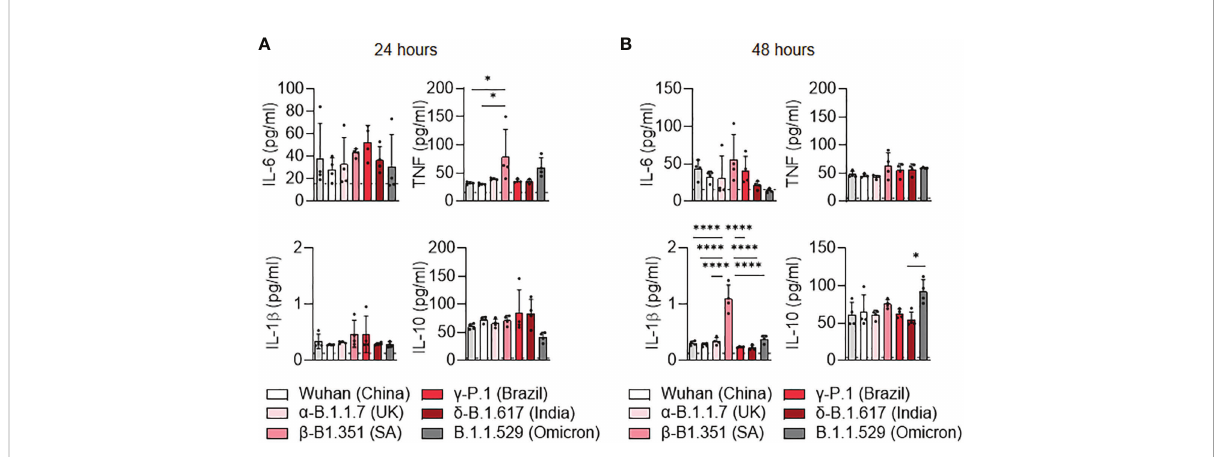
FIGURE 3 Cytokine release of MDM infected with SARS-CoV-2 variants. (A, B) Levels of TNF, IL-6, IL-10 and IL1- b were evaluated in the culture supernatants by ELISA at (A) 24 and (B) 48 hours post-infection. Data values represent the mean ± SEM from 4 healthy donors whose experiments were carried out in triplicate. Statistical analysis was performed with one-way ANOVA and Tukey ’ s multiple comparison test. * p ≤ 0.05 and **** p ≤ 0.0001